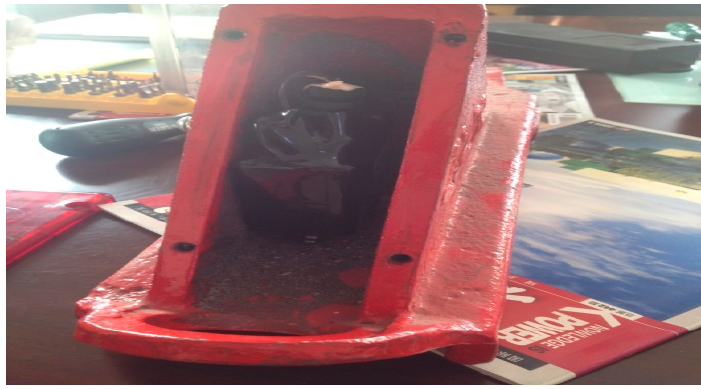
Figure 7. The position of the sensor and its enclosure of a track skate.